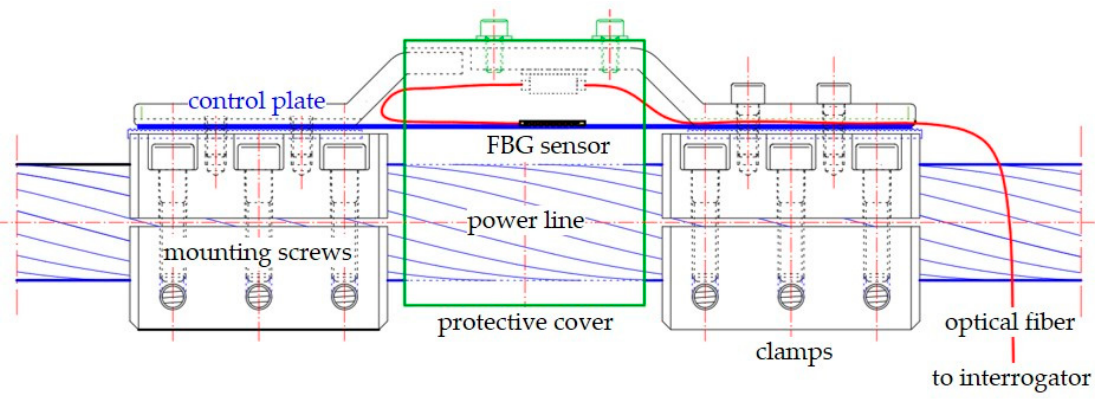
Figure 5. The elongation transformer used in tests of sag measurement.